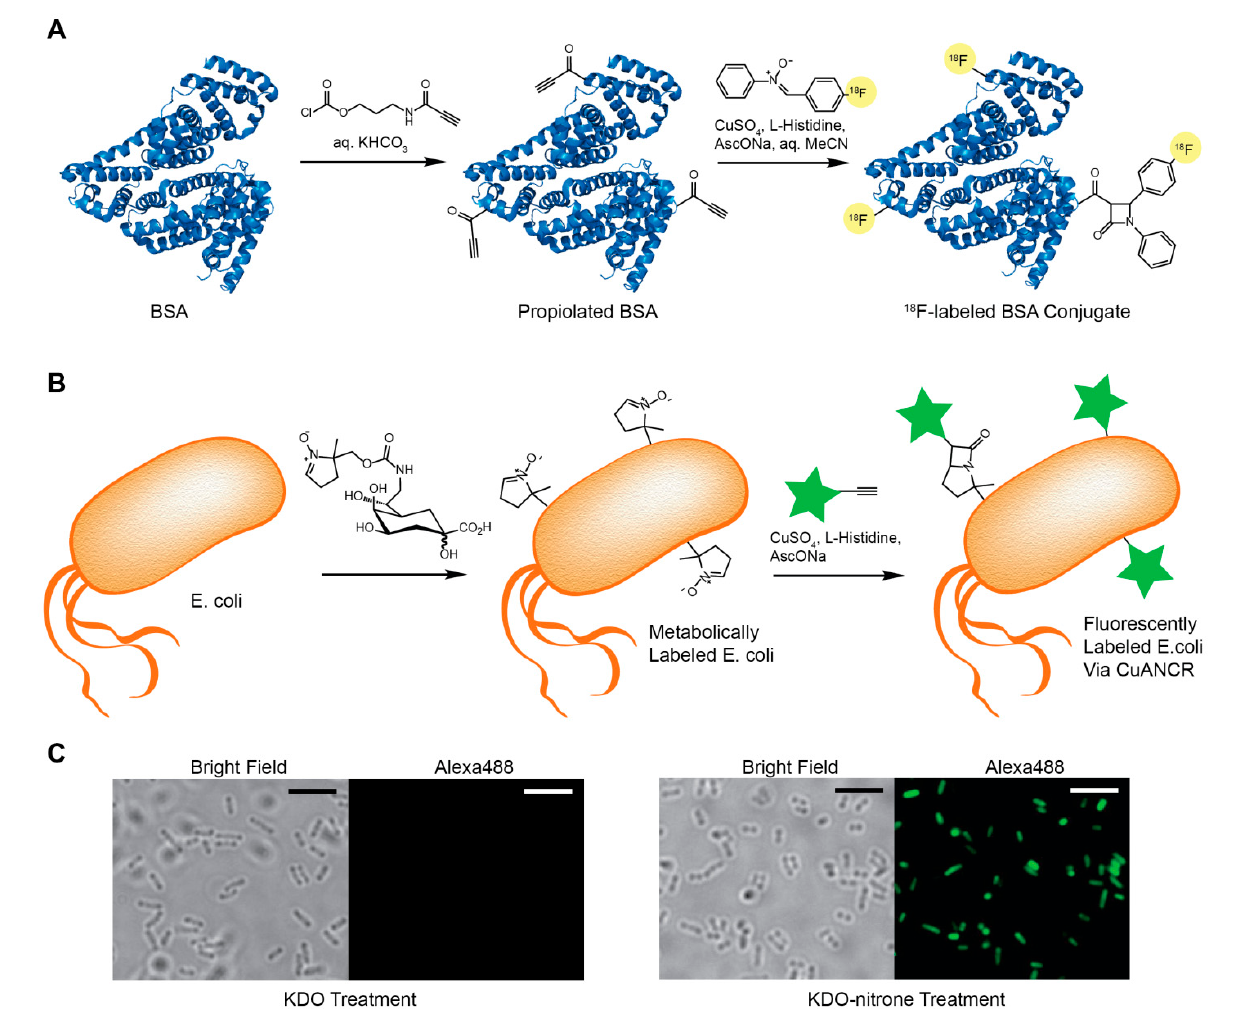
Figure 1. Bioorthogonal labelling by the Kinugasa reaction. ( A ) 18 F-BSA conjugate formation by the radio-Kinugasa reaction by Cu(I)-histidine catalysis in aqueous acetonitrile. BSA (PDB 3V03) is propiolated using the indicated acylating agent, and then reacted with 18 F- N -phenyl nitrone to produce an 18 F-labelled BSA conjugate. Adapted from [37] ( B ) Metabolic labelling and fluorophore conjugation of living E. coli by copper-catalyzed alkyne-nitrone cycloaddition and rearrangement (CuANCR). Gram negative bacteria cultured in the presence of KDO-nitrone incorporate the functionalized sugar into the inner core of LPS molecules. Incorporated nitrone is detected after Cu(I)-histidine catalysis for the conjugation of an alkyne-tagged reporter. Adapted from [13] ( C ) Fluorescence microscopy of E. coli cultured in the presence of KDO (left) and KDO-nitrone (right) after CuANCR labelling with Alexa488-alkyne. Scale bar = 5